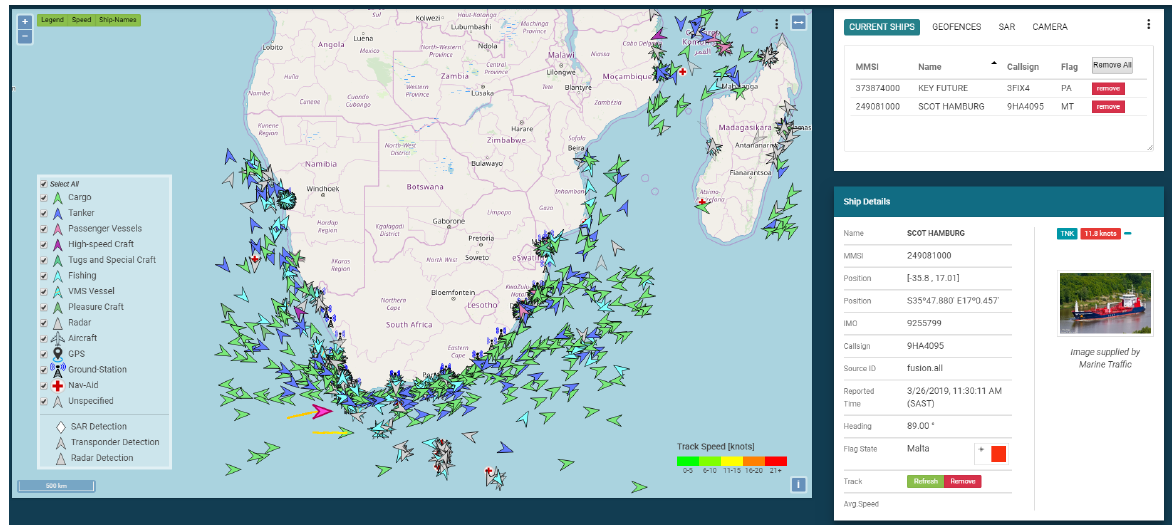
Figure 2. The OCIMS Integrated Vessel Tracking